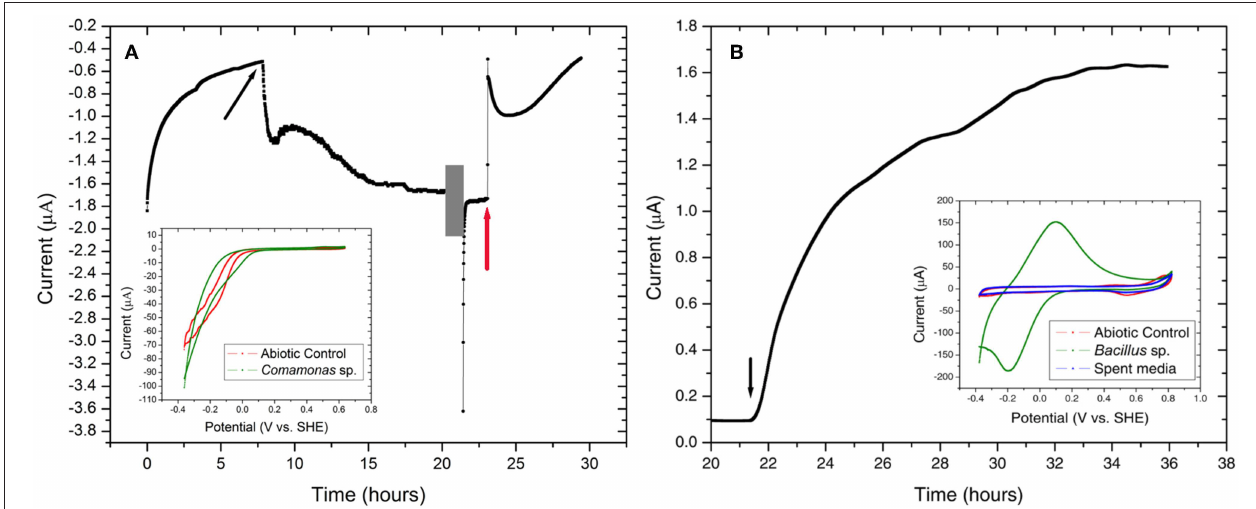
FIGURE 8 | Chronoamperometry of the isolated strains (A) Comamonas sp. (strain WE1-1D1) and (B) Bacillus sp. (strain WE4-1A1-BC) grown at − 0.012V vs. SHE and + 0.53V vs. SHE, respectively. (A) An increase in cathodic current was observed with the addition of Comamonas sp. (strain WE1-1D1) (black arrow) to the electrochemical cell. At 20h (gray box), CV (inset) was performed on the electrode-attached biofilm and potassium cyanide was injected at 23h (red arrow). (B) Bacillus sp. (strain WE4-1A1-BC) was enriched on working electrode poised at + 0.53V vs. SHE with acetate as the electron donor and carbon source. Black arrow indicates the time point when the bioreactor was inoculated with the cells. Cyclic voltammogram of the abiotic control, electrode-attached biofilm and the spent media is shown in the inset.